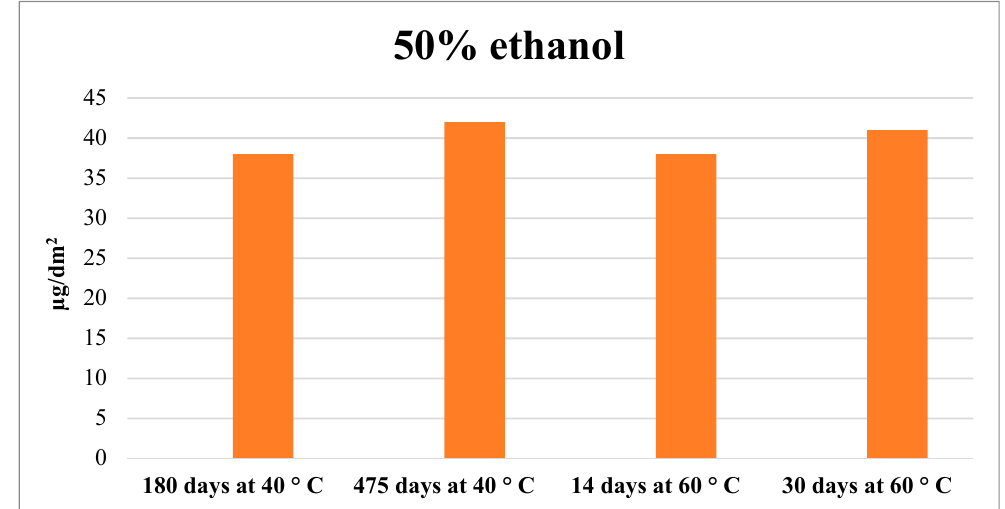
Figure 2. Comparison of migration into 50% ethanol of unknown E at 40 ◦ C (data obtained from Paseiro-Cerrato et al. [34]) and at the accelerated test performed in this study at 60 ◦